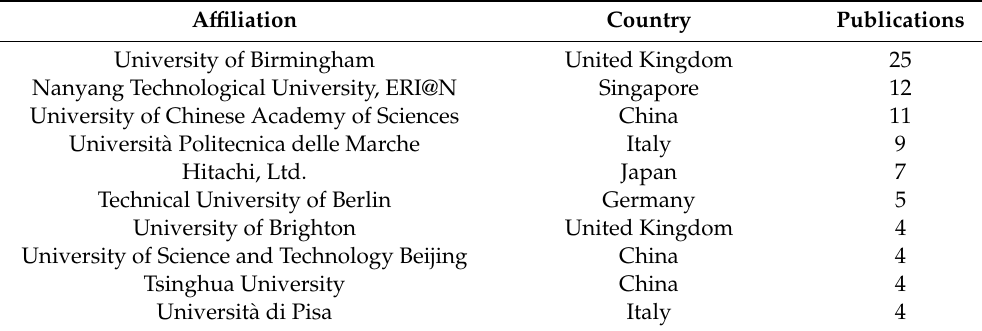
Table 2. Top 10 institutions and their corresponding country.